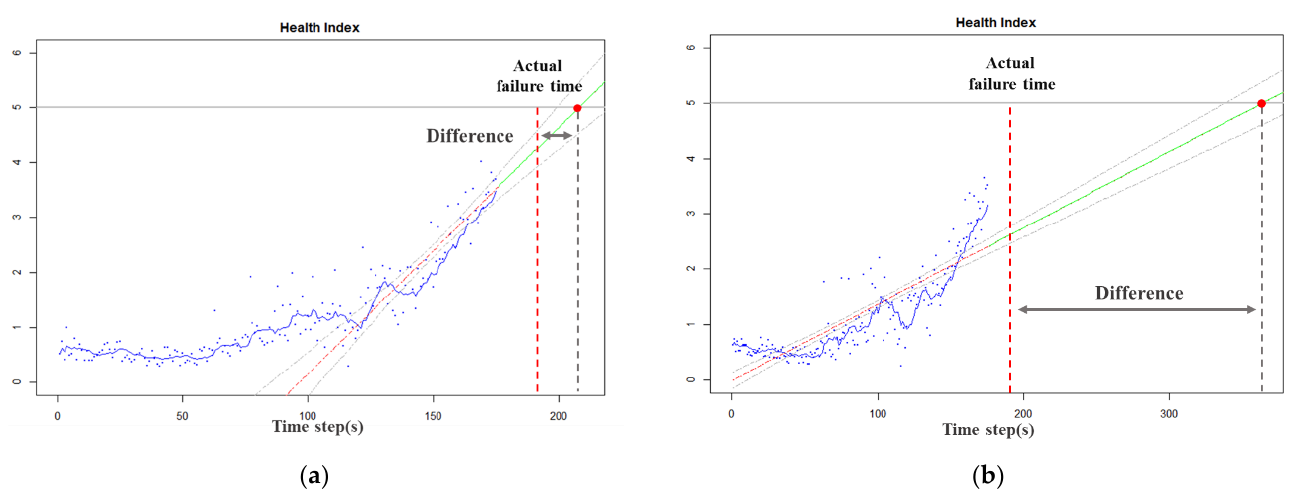
Figure 4. The example of the Health Index and the RUL prediction difference. ( a ) fitting results of the last 50 samples; ( b ) fitting results of the total samples.